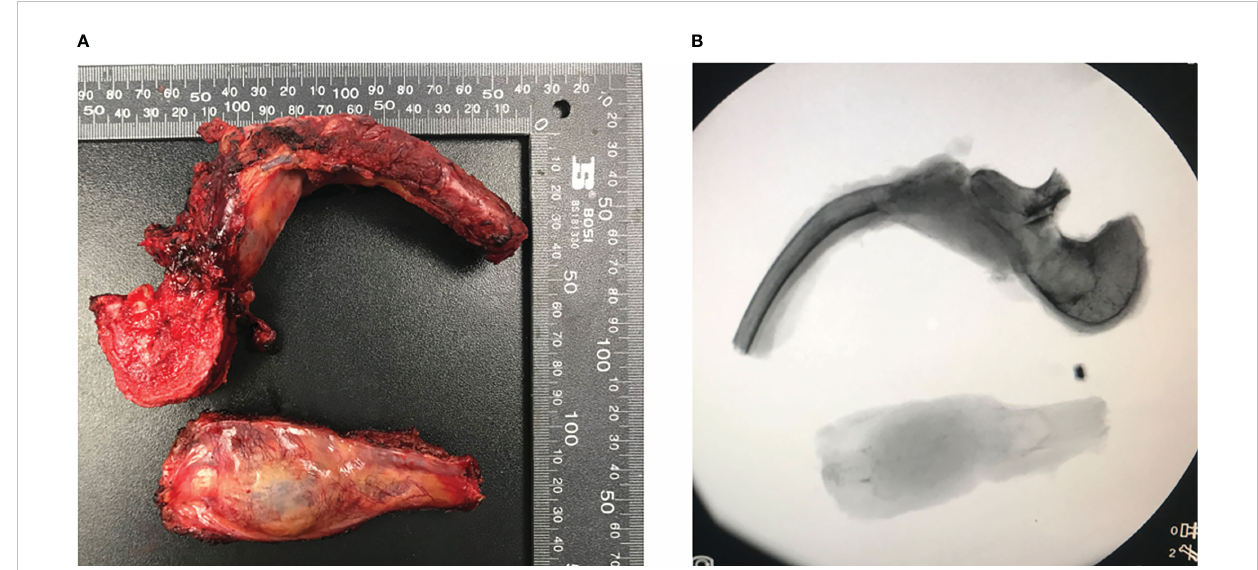
FIGURE 4 En-bloc excision tumor specimen in T8 and part of 7th rib of the patient and corresponding perspective image (A, B) . Both images showed the integrity of tumor and the lesion was completely